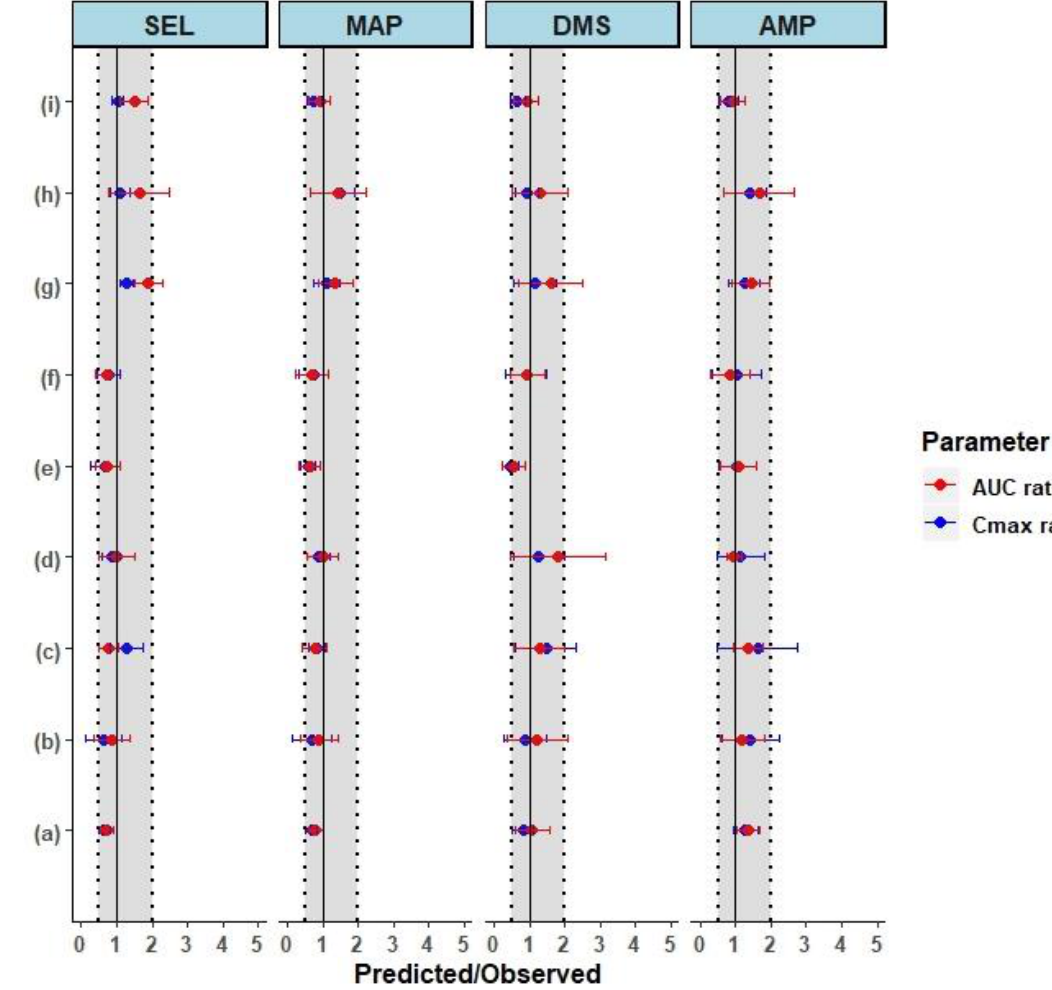
Figure 5. The forest plot shows the mean ± SD predicted in elderly subjects over the observed ratio of pharmacokinetic parameters in healthy subjects. The dotted and shaded area represents the 0.5- to 2- fold range and the solid black line represents the line of unity. The parameters AUC and C max represent the Area Under the Curve 0-t and the maximum plasma concentration, respectively. The compounds SEL: Selegiline, MAP: Methamphetamine, DMS: Desmethyl Selegiline, and AMP: Amphetamine are shown as faceted plots. ( a ) Intravenous infusion at 8.37 mg/kg for 24 h; ( b ) single 24 h; ( b ) single dose Transdermal pharmacokinetics in healthy male adults at 20 mg / 20 cm 2 for 24 h; dose Transdermal pharmacokinetics in healthy male adults at 20 mg/20 cm 2 for 24 h; ( c ) single dose ( c ) single dose Transdermal pharmacokinetics in healthy male and female adults at 20 mg / 20 cm 2 for 168 h; ( d ) single dose Transdermal pharmacokinetics in six male healthy adults at 18.3 mg / 10 cm 2 for 24 h; ( e ) single dose Transdermal pharmacokinetics in six healthy elderly males at 18.3 mg / 10 cm 2 18.3 mg / 10 cm 2 for 24 h; ( g ) multiple dose Transdermal pharmacokinetics in healthy elderly